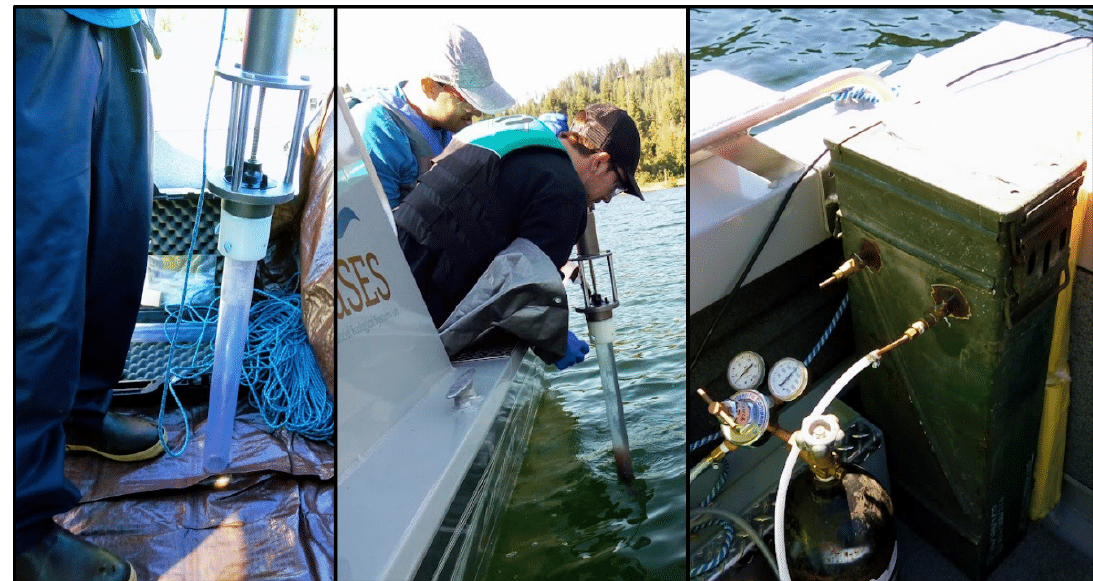
Figure 4. Kajak–Brinkhurst gravity corer, free fall use from the University of Idaho Lake Social Ecological Systems boat in Coeur d’Alene Lake, and storage of the cores in the gas-tight containers with an N 2 source for atmosphere flushing.